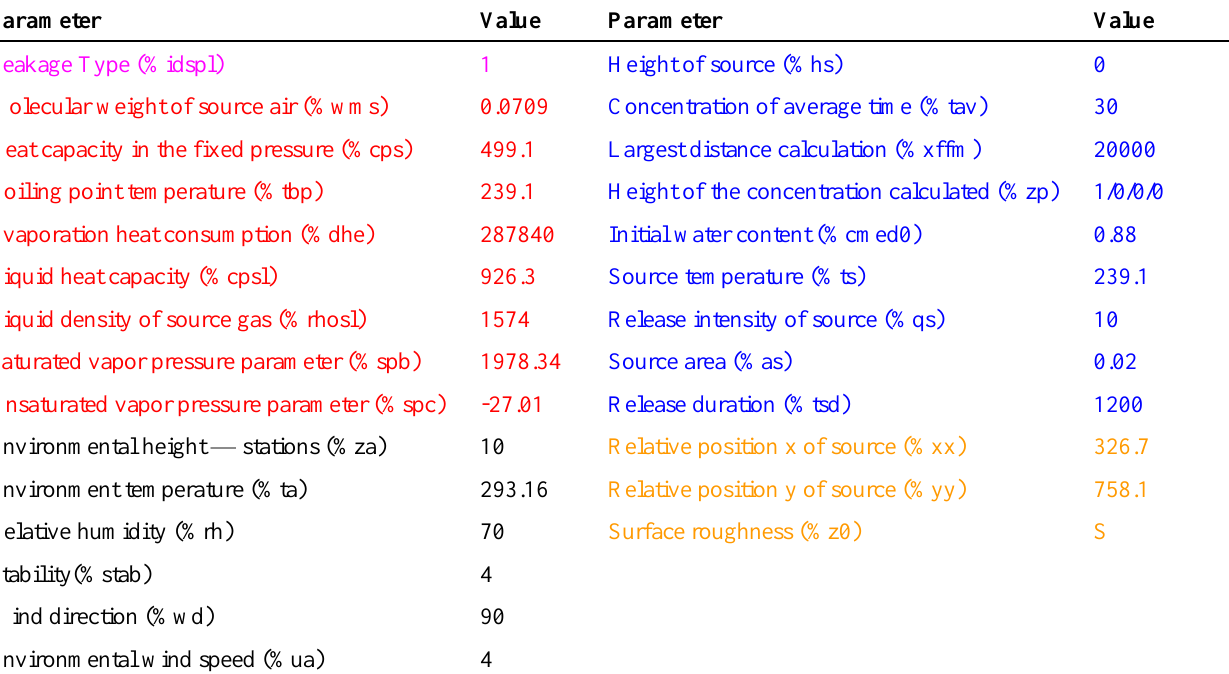
Table 1. Input parameter of the Atmospheric Dispersion Model for Denser than Air Releases (SLAB) model, for the chlorine example. The pink text indicates the leakage type; the red text represents the physicochemical properties of leakage substance; the blue text is the leakage status parameters; the black text is the meteorological conditions; and the yellow text signifies the regional